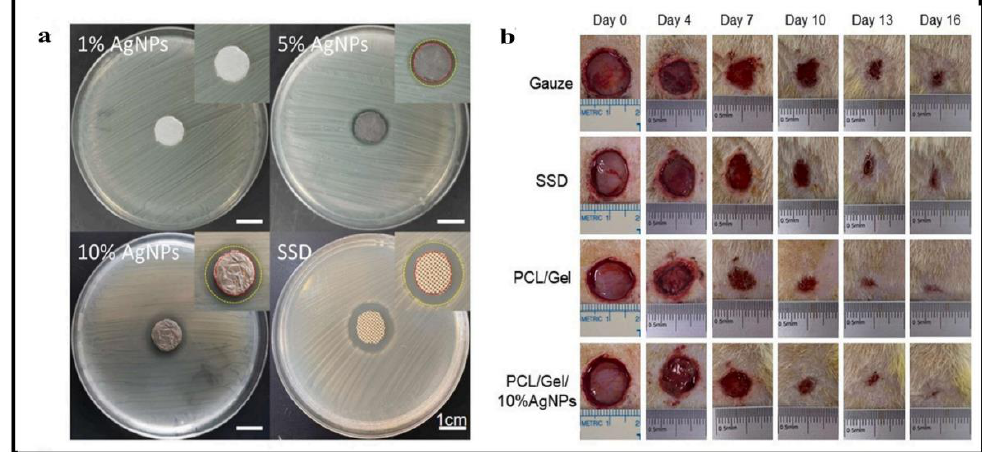
Figure 10. ( a ) Representative photograph showing the antibacterial zones of E. coli growth inhibition by the different dressings. ( b ) Photographs show the wound healing process at different time points; images reproduced with permission from [168] © 2021 Materials Science & Engineering C. Published by Elsevier Ltd.